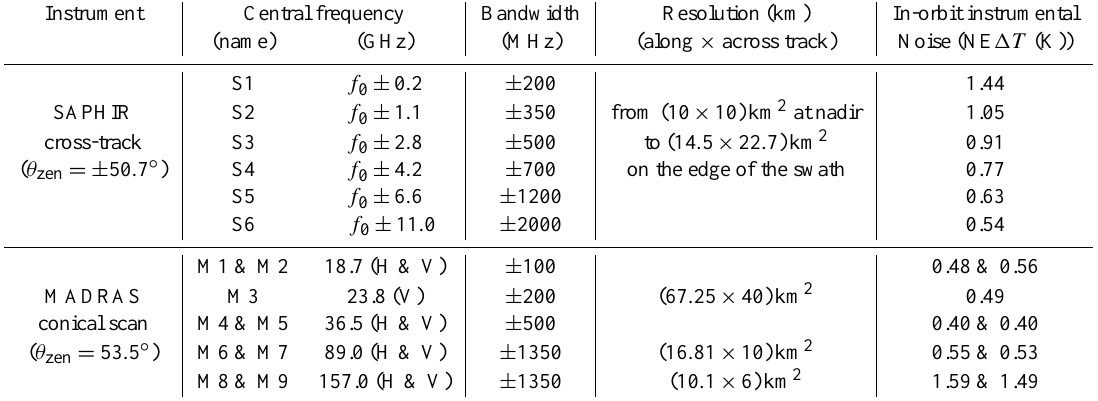
Table 1. Observational characteristics of SAPHIR and MADRAS. θ zen is the viewing zenith angle. “H” and “V” correspond respectively to the horizontal and vertical polarizations of the observed electromagnetic field. f 0 corresponds to SAPHIR central frequency at 183.31GHz. The instrumental noises obtained from in-orbit performance are also indicated (from Karouche et al., 2012). Instrument Central frequency Bandwidth Resolution (km) In-orbit instrumental (name) (GHz) (MHz) (along × across track) Noise (NE (cid:49)T (K)) S1 f 0 ± 0 . 2 SAPHIR S2 f 0 ± 1 .